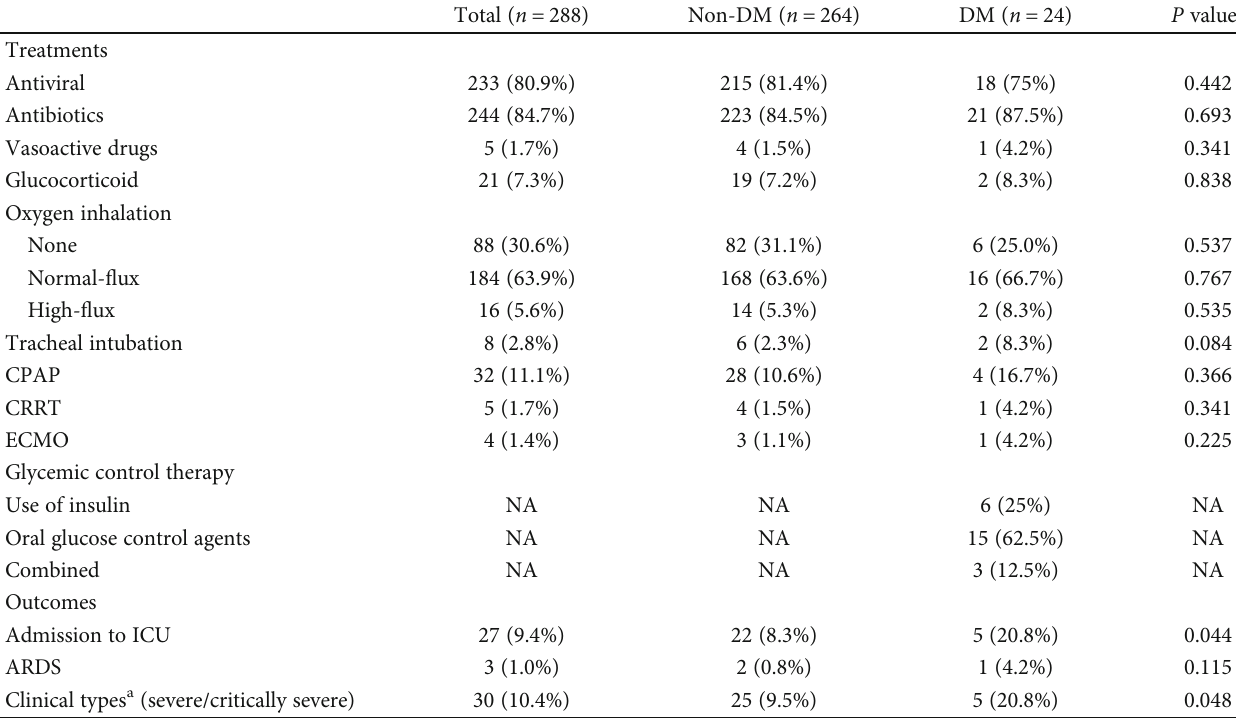
Table 2: Treatments and outcomes of COVID-19 patients with non-DM or DM.